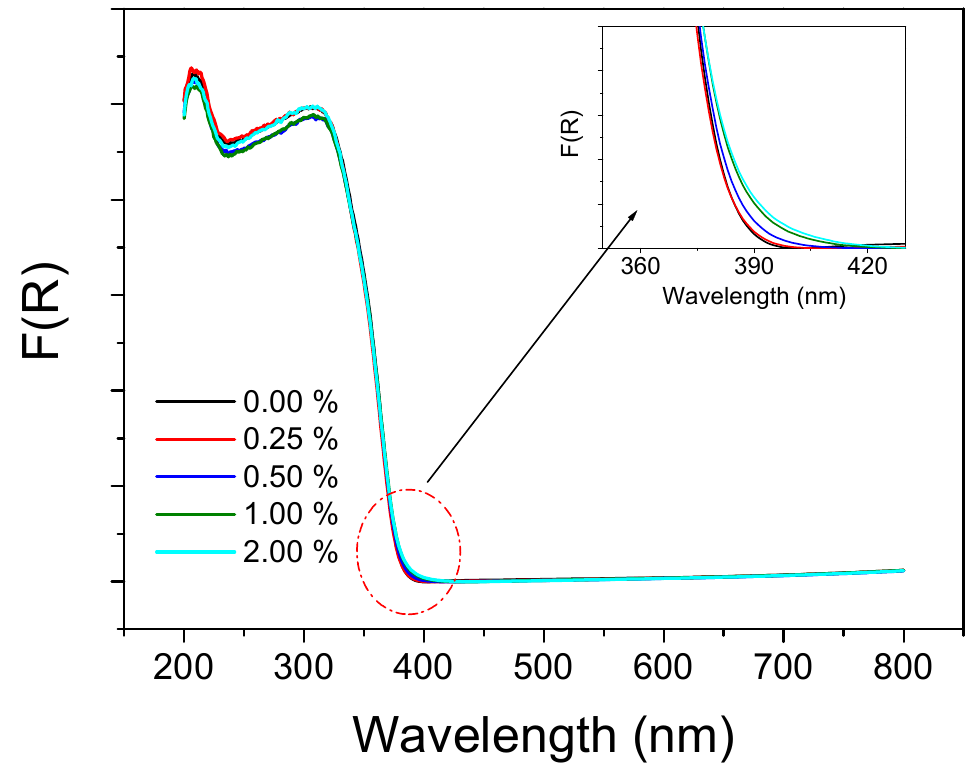
Figure 7. F(R) plots of Ce–Sm co-doped TiO 2 samples. Inset shows an enlarged view of the absorption edges of different compositions.